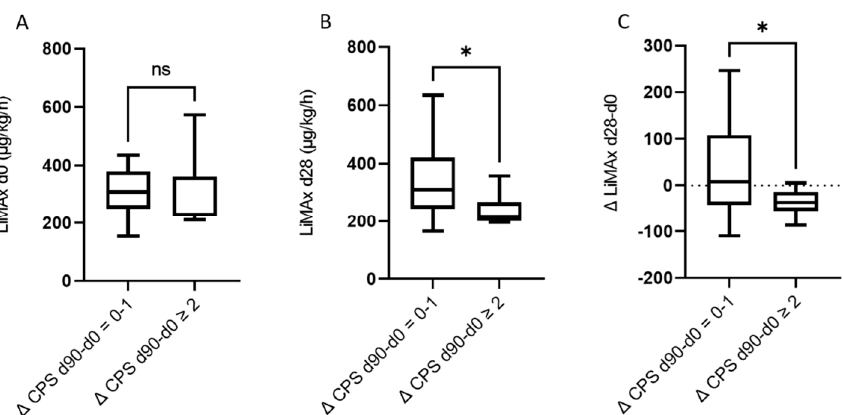
Figure 5. ( A ) No significant difference in baseline LiMAx for patients with or without deterioration in Child–Pugh score 90 days after RE. ( B ) Patients with at least two points decline in Child–Pugh score at d90 presented a significantly lower LiMAx at d28, only prospective cohort ( Δ CPS d90-d0 = 0–1 median baseline LiMAx 311 µg/kg/h, IQR 243.5–420.5 µg/kg/h, Δ CPS d90-d0 ≥ 2 median baseline LiMAx 216 µg/kg/h, IQR 200.8–267 µg/kg/h, p = 0.05; ( C ) Patients without any deterioration in Child–Pugh score showed unchanged LiMAx values at d28. Patients with a deterioration in Child–Pugh score by at least two points at day 90 had slightly worsened LiMAx values, only prospective cohort. * = p < 0.05, ns = not significant.